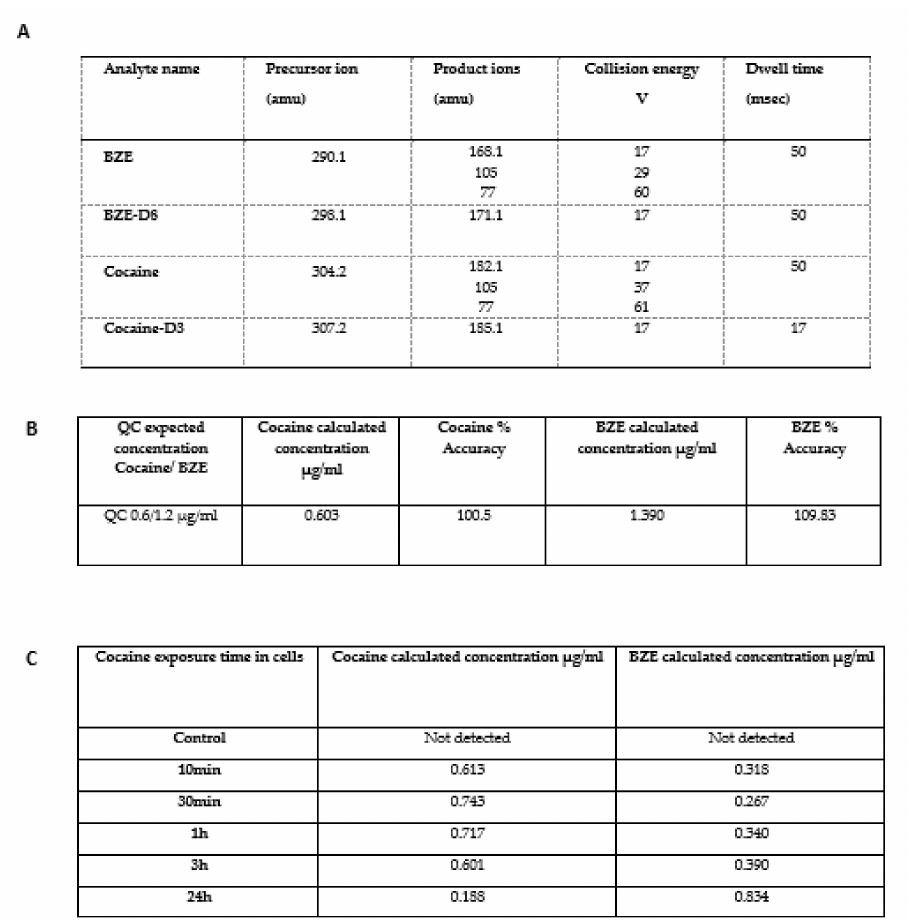
Figure 6. Cardiomyocytes metabolise cocaine to BZE over a 24-h time period. ( A ) a LC-MS method was developed to detect cocaine and BZE in cell media using deuterated internal standards. The ion transitions for each analyte are detailed above. ( B ) In all analysis quality control samples (QC) of extracted spiked media were run alongside samples. These QC demonstrated a calculated concentration accuracy of 90–110%. ( C ) Cells were spiked with 1 ug/mL of cocaine and surrounding media concentration monitored over 24 h. there was a decrease in cocaine concentrations and a concomitant increase in BZE concentration suggesting that metabolism of cocaine to BZE occurs in this model. LC-MS results representative of five extractions generated from five independent